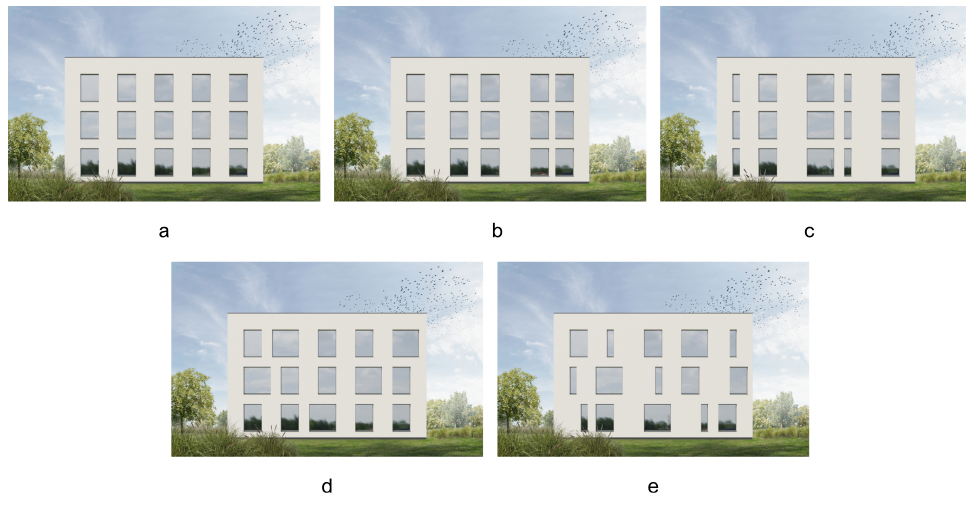
Figure 3. The incentives presented in the study: ( a ) composition no. 1; ( b ) composition no. 2; ( c ) compo- sition no. 3; ( d ) composition no. 4; ( e ) composition no.